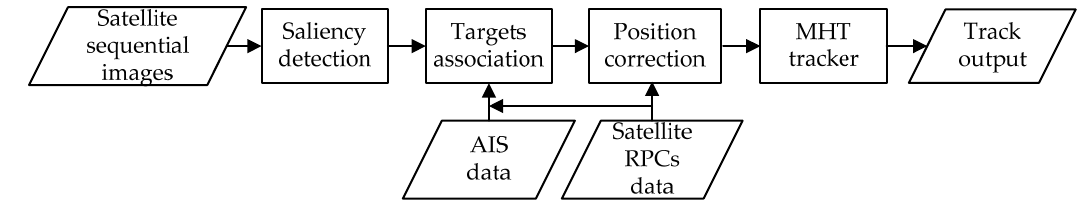
Figure 2. Proposed method framework.